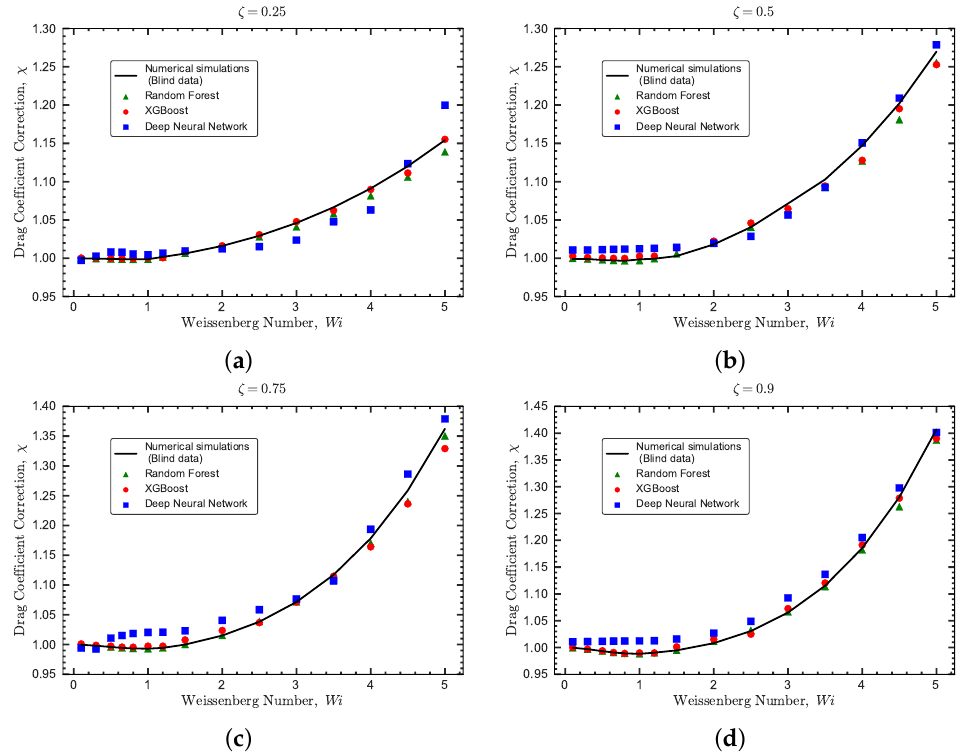
Figure 11. Validation of the ML models against the blind dataset generated for the Oldroyd-B fluid. The comparisons are between the DNSs (solid lines showing the real values for the viscoelastic drag coefficient correction) and the predicted values by the ML models. The comparisons are shown at Re = 1 for different values of ζ : ( a ) ζ = 0.25, ( b ) ζ = 0.5, ( c ) ζ = 0.75 and ( d ) ζ = 0.9. The predictions obtained with the Deep Neural Network, Random Forest and XGBoost models are represented by square, triangle and circle symbols,